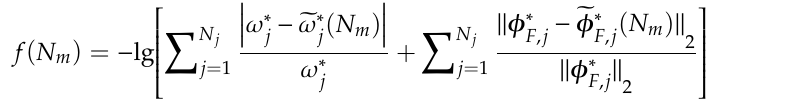
Table 1. The simulated damage cases of the truss structure.